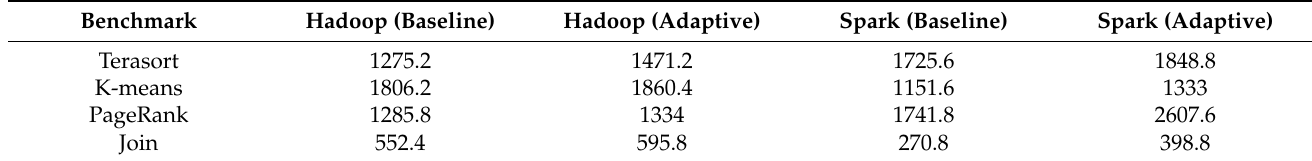
Table 4. Summary of single-container executions (sec).